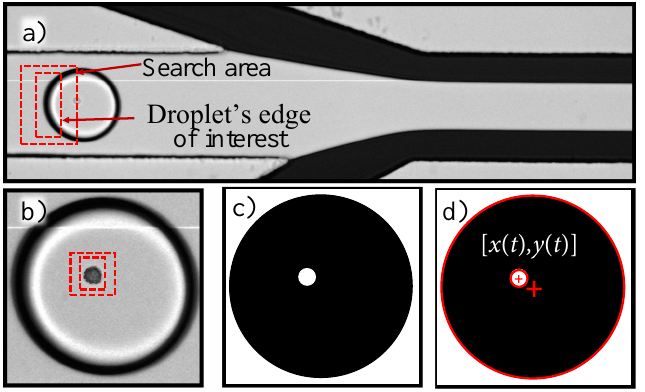
Figure 7. Image sequence processing approach: ( a ) droplet edge is detected and tracked within a defined search area, ( b ) cell is detected and tracked within a defined search area, ( c ) image sequence is converted to black stagnant droplet containing a white moving cell, ( d ) cell position is recorded at every time frame using circular Hough